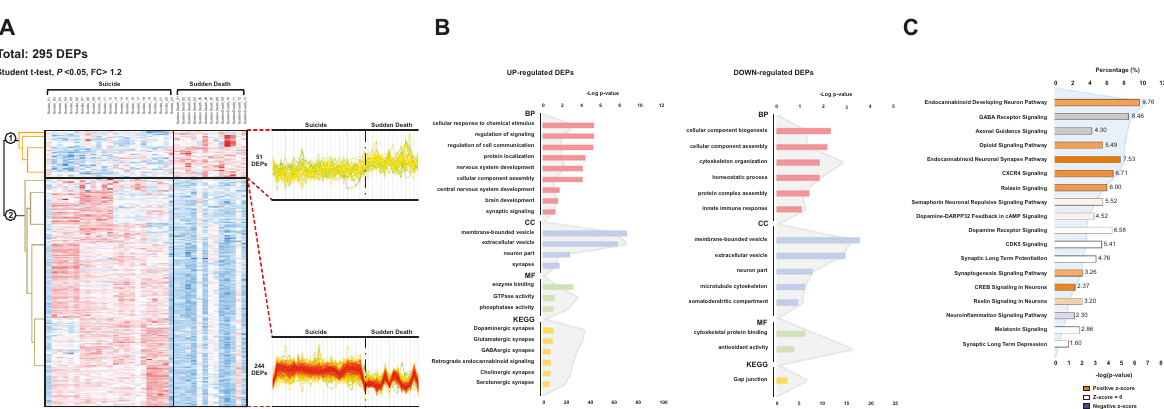
Fig. 2 Differentially expressed proteins and GO, IPA analysis results. A Hierarchical heat map clusters of signi fi cant proteins by Student ’ s t -test B GO analysis using 244 upregulated DEPs and 51 downregulated DEPs. Each colored bar graph indicates the enriched terms in biological process (BP), cellular component (CC), molecular function (MF), and KEGG pathway. The number of participating proteins is shown on the lower axis, and log p -value for the upper axis (gray line graph) for GO terms. C Ingenuity pathway analysis (IPA) results for functional analysis. The percentage of participating proteins is shown on the upper axis, and the log p -value for canonical pathways in the lower axis (blue line graph). The z -score of each canonical pathway is represented by bar